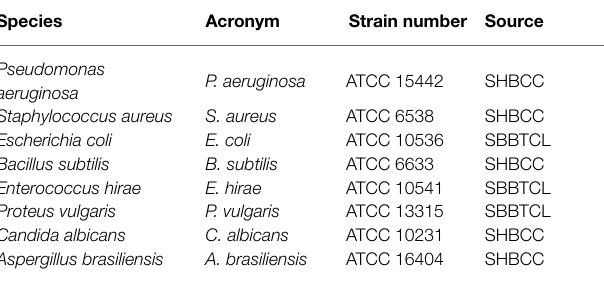
TABLE 2 | ATCC standard strains for